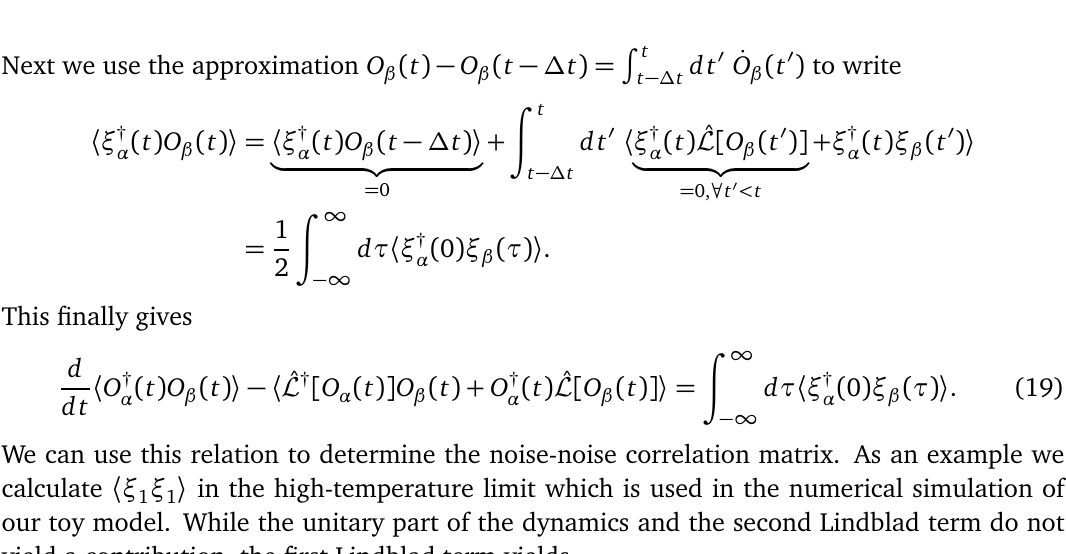
Figure 6: Domain wall density as a function of the coupling strength ˜ ε = ( Ja 2 / D ) ε . The solid line shows the exponential fit ˜ A ˜ ε 1 / 4 e − ˜ c / ˜ c = 0.98 ˜ A = ( 4.4 ± 0.06 ) · 10 − 2 . Parameters: L = 10000, γ = 0.875, 2 D χ T = 0. Results are obtained by averaging over ten noise